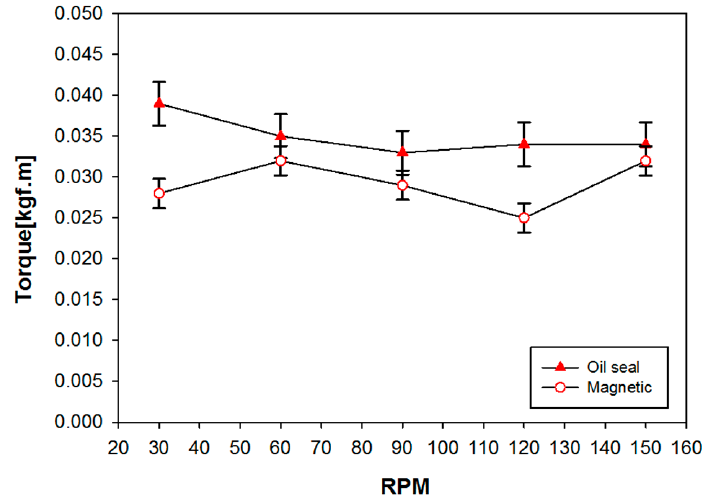
Figure 11. Oil seal and magnetic coupling torque mechanical loss.